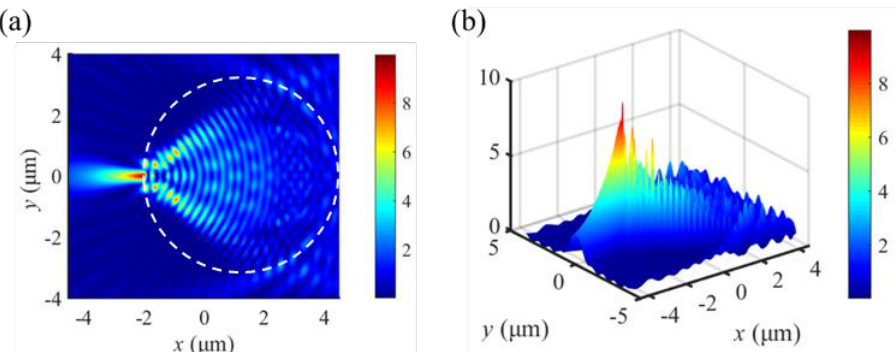
Figure 2. FDTD − computed optical field intensity formed by different dielectric microdisks. ( a ) Two − dimensional (2D) simulation results of intensity distributions on the x − y plane, ( b ) three − dimensional (3D) simulation results for the intensity distributions.